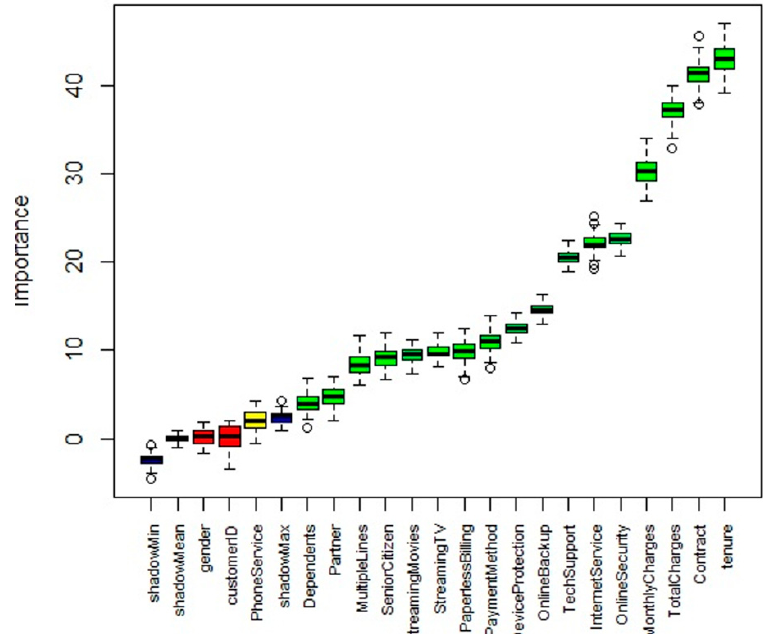
Figure 3. The distribution of churn features based on importance score in Boruta algorithm.